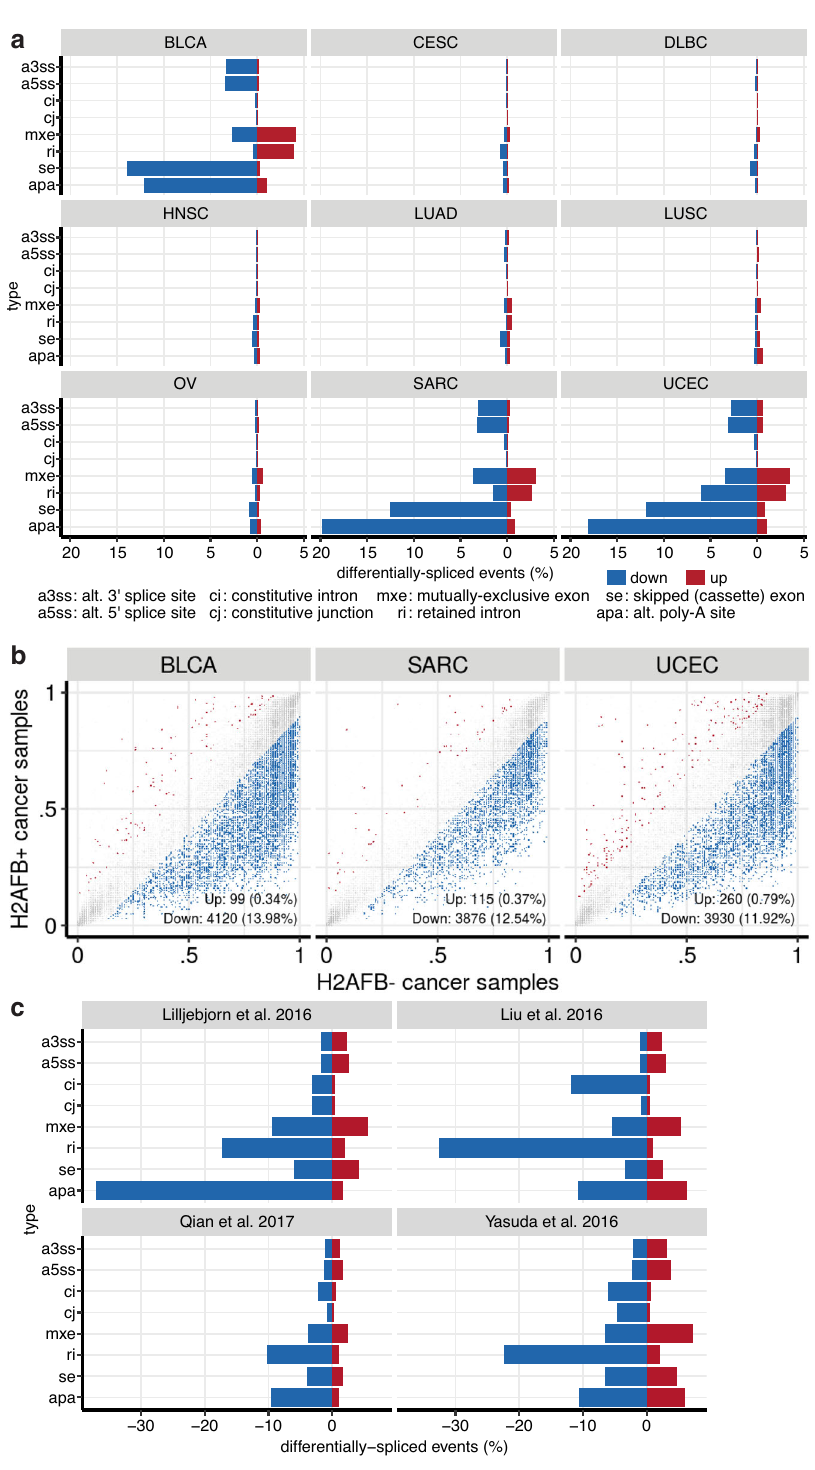
Fig. 4 Splicing analyses in H2A.B-reactivated cancers. a Bar graphs showing the percentage of up- and downregulated splicing events (constitutive and alternative) when comparing H2A.B-positive to negative tumors, for cancer types with at least 10 tumors expressing any H2A.B paralogue. b Scatter plots of alternative cassette exon inclusion for various cancers, comparing individual events from H2A.B-positive ( y axes) to negative tumors ( x axes). Axes units are fraction of transcripts that include the alternative cassette exon (Psi). Red and blue points indicate events that are signi fi cantly up- or downregulated (respectively) in H2A.B-positive tumors, at a threshold of p < 0.05 (one-sided Mann – Whitney test) and the difference in Psi >0.1. The number of signi fi cantly up- and downregulated events are tallied in the bottom of each panel. c As in a , but for B-ALL data